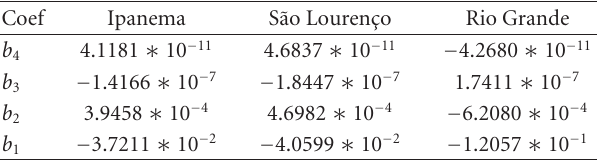
Table 1: Polynomial coe ffi cients (coef) of the measurement